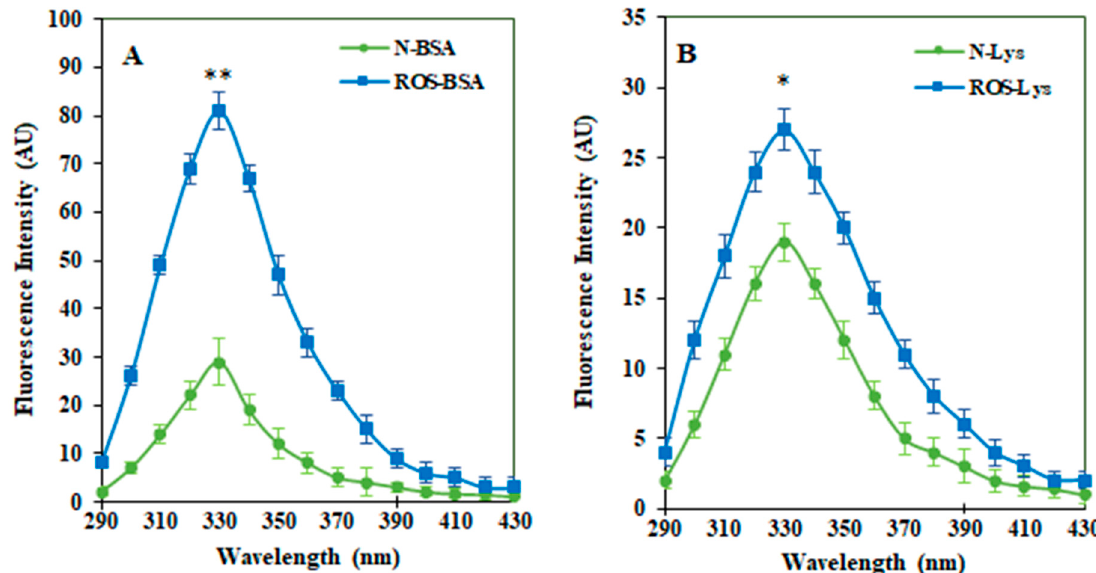
Figure 2. Tryptophan-specific fluorescence of native and free-radical-modified proteins BSA ( A ) and Lys ( B ). The comparison of tryptophan-specific intensities between native BSA and ROS-BSA showed